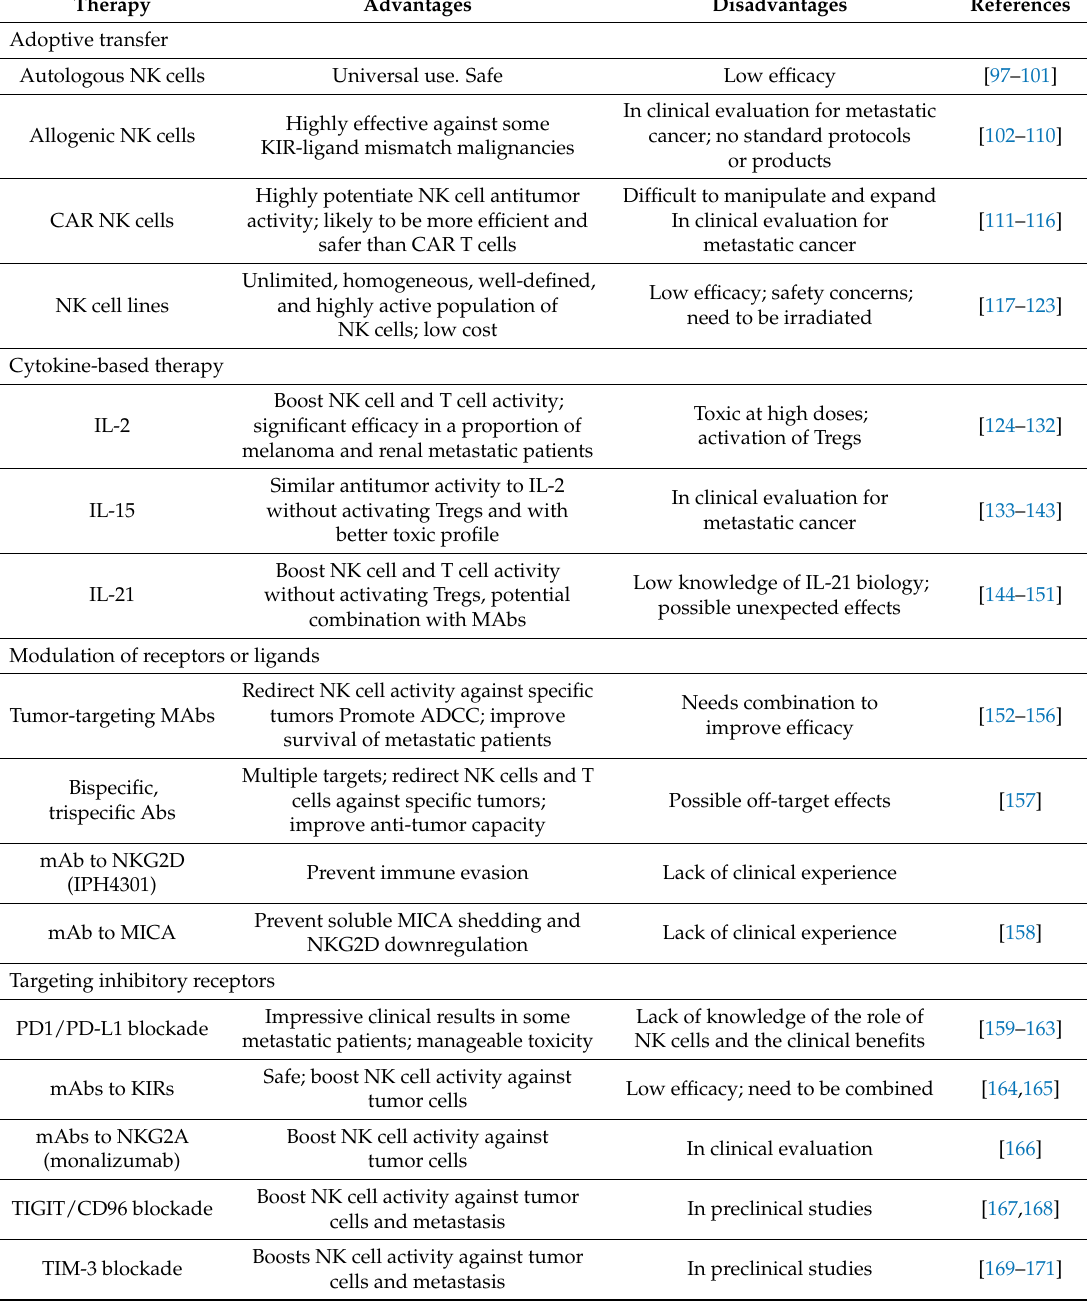
Table 1. The most innovative NK cell immunotherapies for targeting